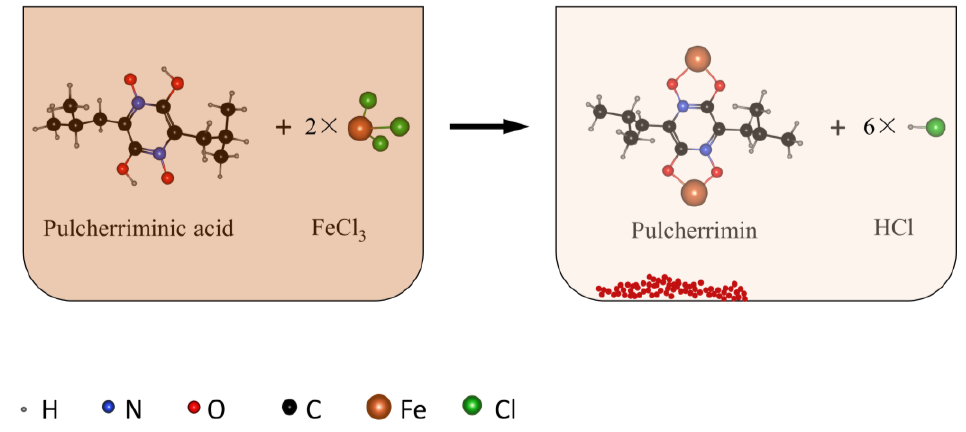
Figure 1. Binding process of pulcherriminic acid with iron ion (red–brown precipitate: pulcherrimin).